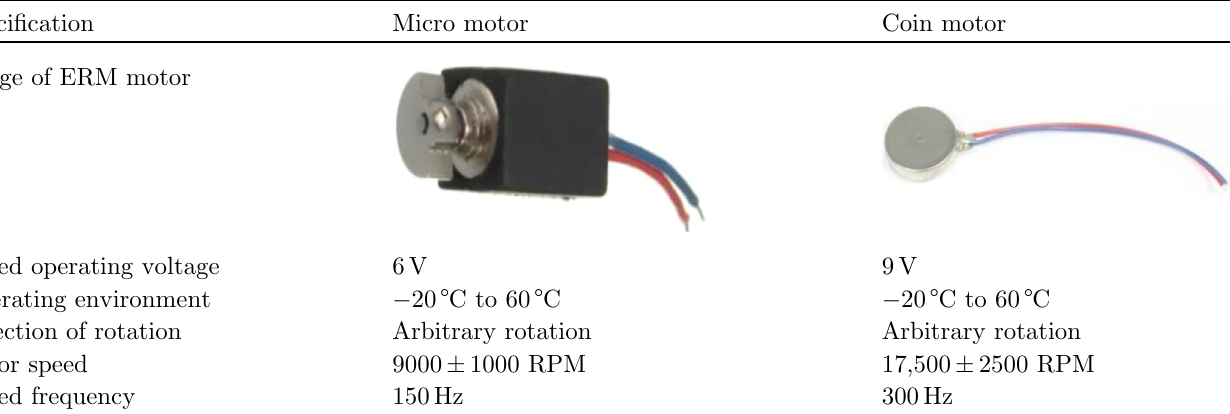
Table 2. Speci fi cation of the ERM